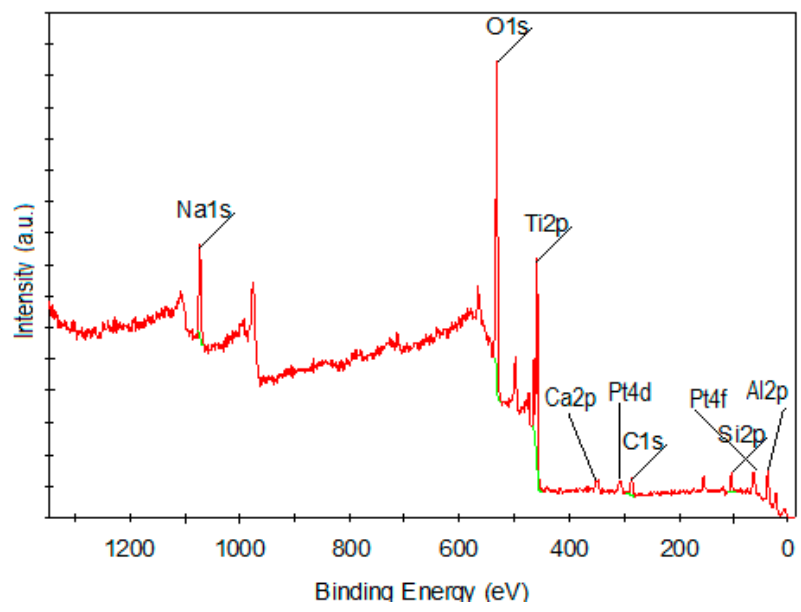
Figure 8. XPS spectrum of FADPt composite.